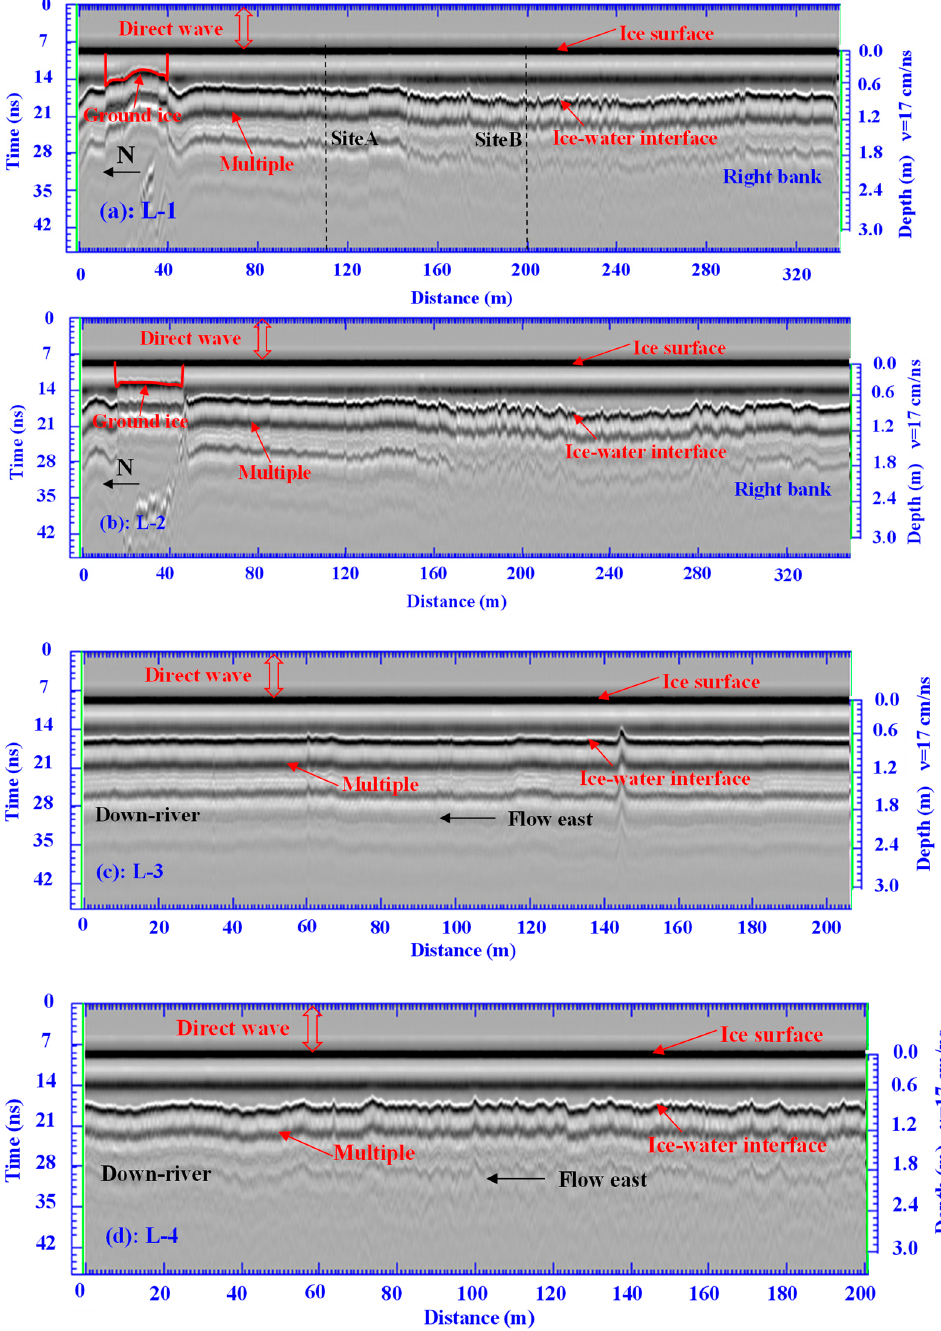
Figure 8. The 200 MHz GPR image profiles measured on 15 February 2014, with direct air and surface-coupled waves retained. The left side is north in images ( a , b ), while the left side is east in ( c , d ); the location of ice core drilling points in ( a ) is marked with a dotted line. Depth on the right vertical axis was estimated by converting two-way travel time to distance for observed reflection using a signal velocity of 0.17 m/ns in freshwater ice.